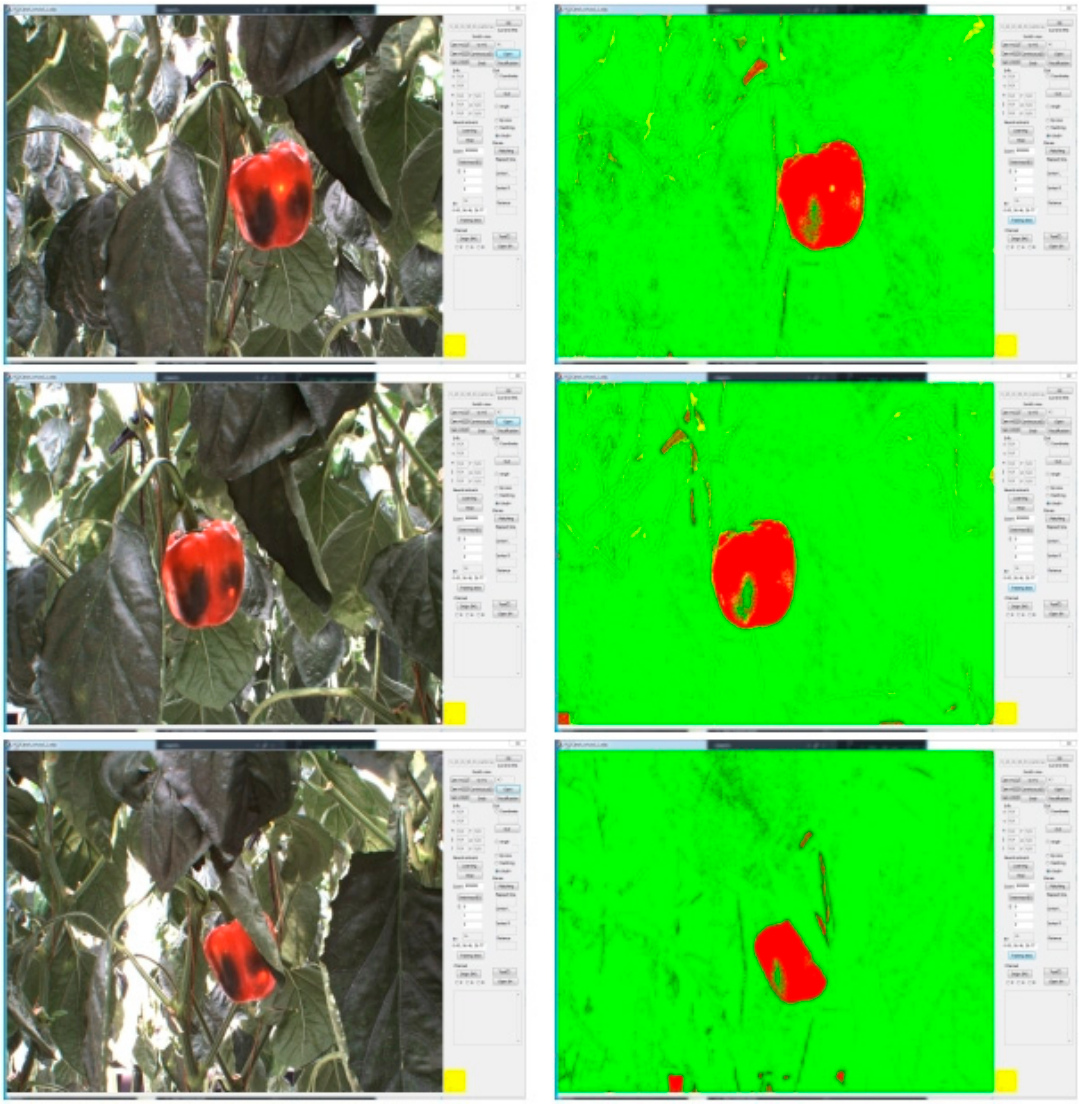
Figure 16. Activation images using the backpropagation algorithm (red sweet pepper).